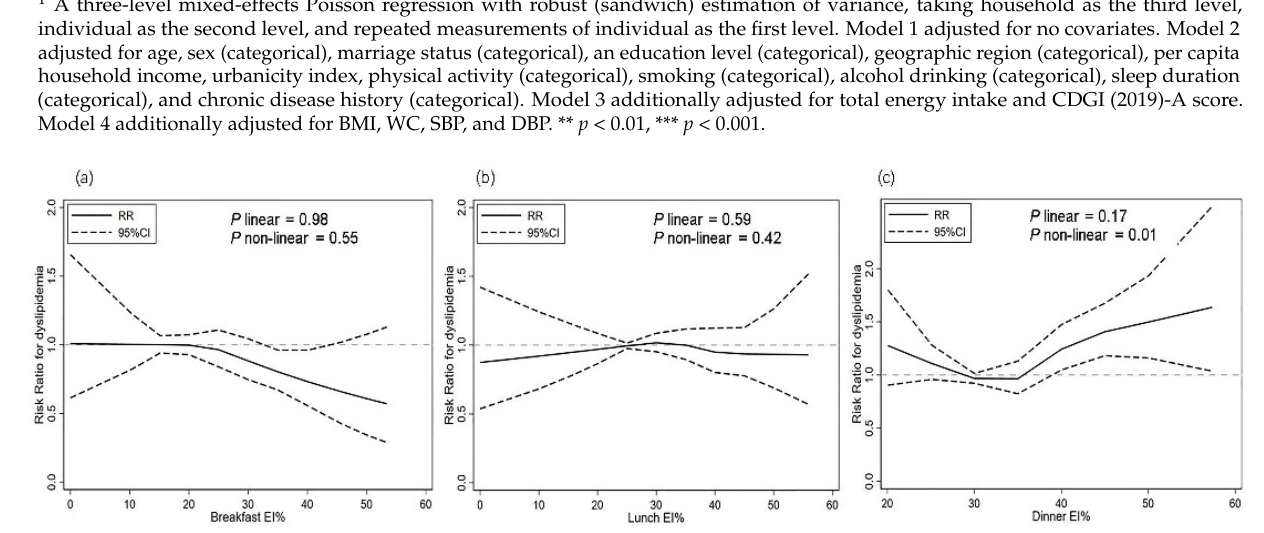
Figure 2. Exposure-response relationships between energy intake proportion at main meals and risk of dyslipidemia by restricted cubic spline for adjusted modified Poisson regression model with robust (sandwich) estimation of variance; EI%, energy intake proportion; ( a ) breakfast energy intake proportion and risk for dyslipidemia; ( b ) lunch energy intake proportion and risk for dyslipidemia; ( c ) dinner energy intake proportion and risk for dyslipidemia.